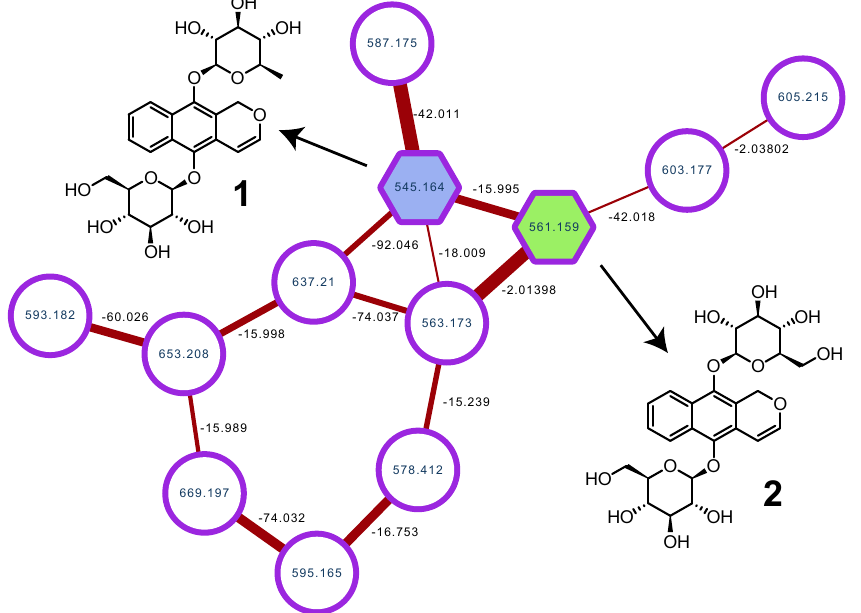
Figure 2. Selected cluster containing clarinoside ( 1 ) and harounoside ( 2